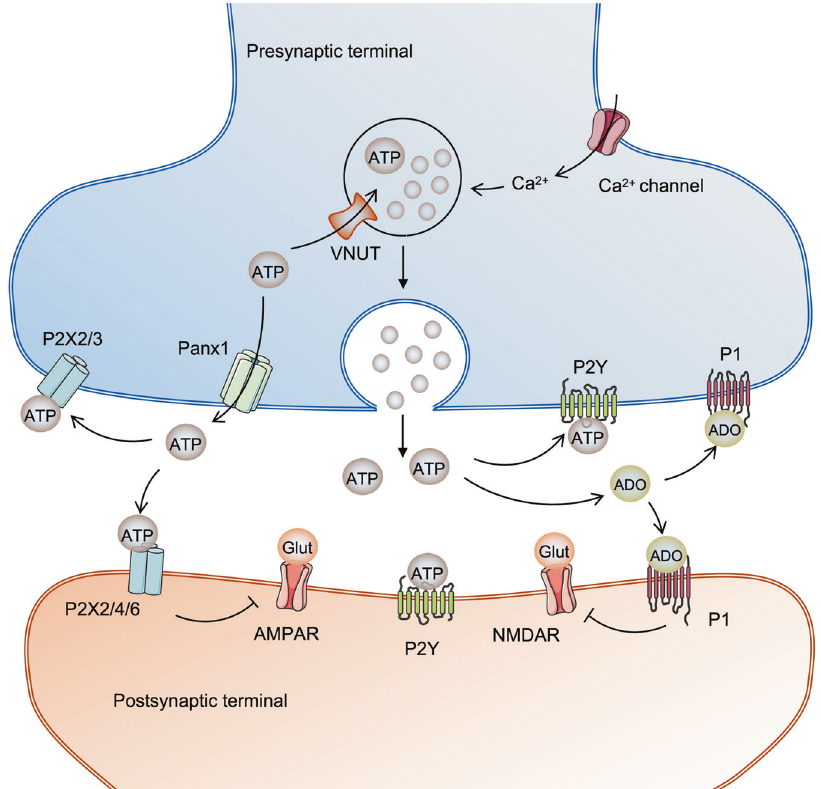
Fig. 4 Purinoceptors mediates neurotransmission in nervus system. In presynaptic terminal, ATP is enriched in vesicles by transporter VNUT and then released in a Ca 2 + -dependent manner, or exported by other channels such as Panx1 independent of Ca 2 + . On one hand, extracellular ATP and its degradation product adenosine in turn activate purinoceptors in presynaptic terminal. This effect may regulate the release of other transmitters such as glutamate. On the other hand, extracellular ATP and adenosine can interact with postsynaptic purinoceptors, thereby regulating the excitability of neural cells. This event might also lead to the internalisation of AMPAR and NMDAR on postsynaptic membrane, leading to a decrease of glutamate-induced current. VNUT vesicular nucleotide transporter, Panx1 pannexin 1, AD adenosine, AMPAR AMPA receptor, NMDAR N-methyl- D -aspartate